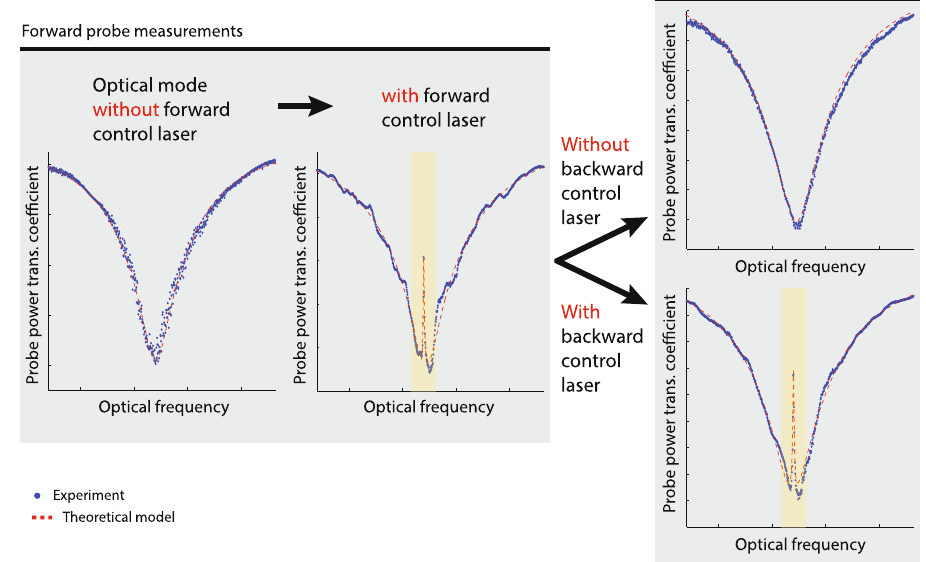
Figure 5. Demonstrating reconfigurable optical isolation. Increasing the control laser power in the forward direction, we observe the appearance of the acousto-optical transparency. While transparency is enabled in the forward direction, we can switch on and off the transparency in the backward direction using a separate backward propagating control laser. The red dashed line represents a fit using theoretical model for induced